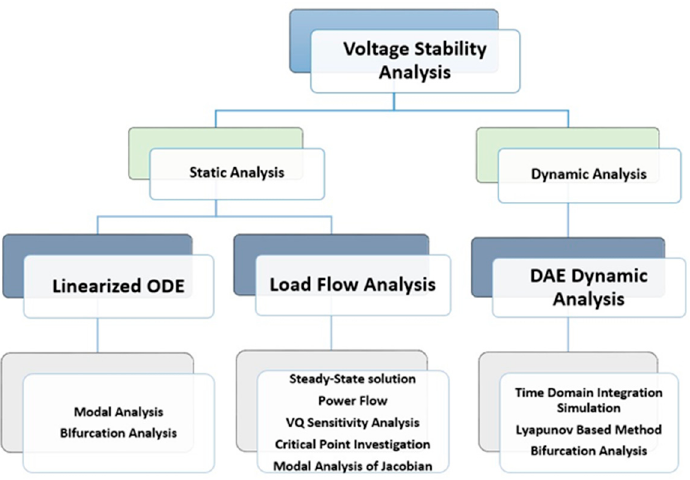
Figure 5. Voltage stability analysis in microgrids.